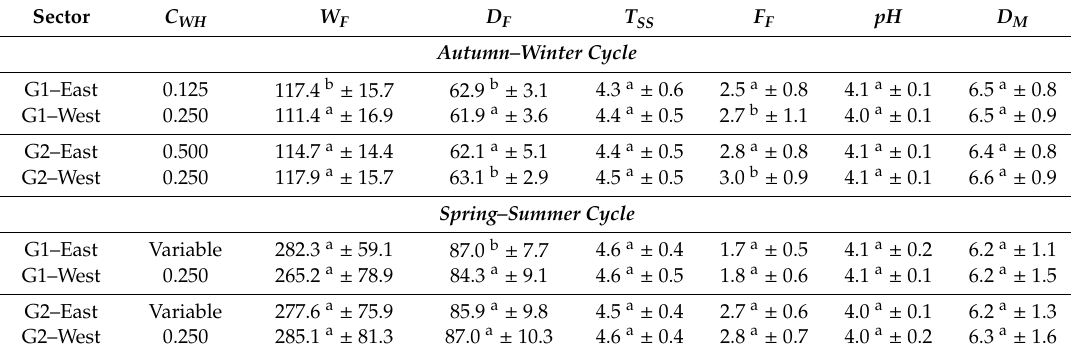
Table 7. Mean ( ± standard deviation) quality parameters of fruit produced in both growing cycles in sectors with di ff erent whitening concentration C WH (kg L − 1 ): Weight W F (g), equatorial diameter D F dry matter D M